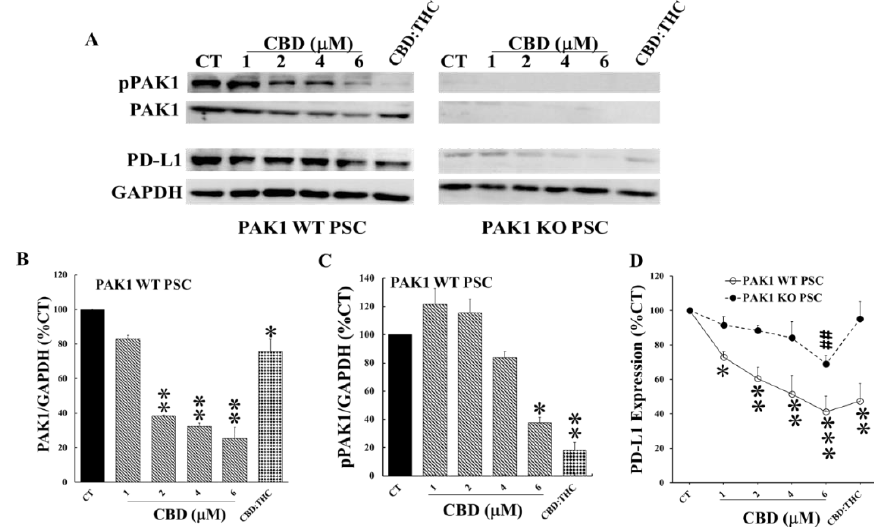
Figure 5. CBD and THC inhibited PD-L1 expression of PSC cells by decreasing PAK1 activity. PAK1 wild type (WT) and knockout (KO) murine pancreatic stellate cells (PSC) were incubated with CBD or CBD plus THC (1 µM:1 µM) for 24 h. The cells were lysed, and the cell lysates were subjected to Western blotting with antibodies against total PAK1, active phosphorylated PAK1 (pPAK1), PD-L1 and GAPDH. Two representative blots were shown in ( A ). The relative expression levels of PAK1 ( B ), pPAK1 ( C ) and PD-L1 ( D ) were calculated from three independent sets of experiments while the values obtained from the non-treated controls of PAK1 WT cells were taken as 100%. In ( D ), the non-treated controls for either PAK1 WT or KO were taken as 100% for the treated WT and KO cell line respectively. CT: control. *, p < 0.05; **, p < 0.01, ***, p < 0.001 compared to the values obtained from the non-treated controls of PAK1 WT cells. ##, p < 0.01 compared to the values from the non-treated controls of PAK1 KO cells ( D ).